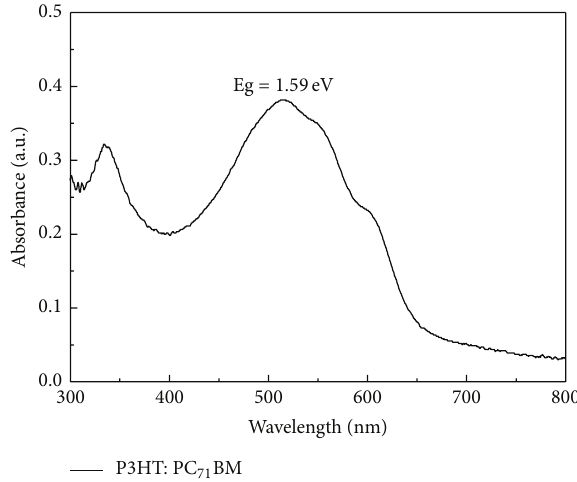
Figure 1: UV-vis absorption spectra of P3HT:PC 71 BM (1: 1) thin film ∼ 100-nm thick, which was formed using a mixed CB/CF solution (Vol/Vol = 3/1) as the solvent and annealed at 130 ∘ C for 20 min.